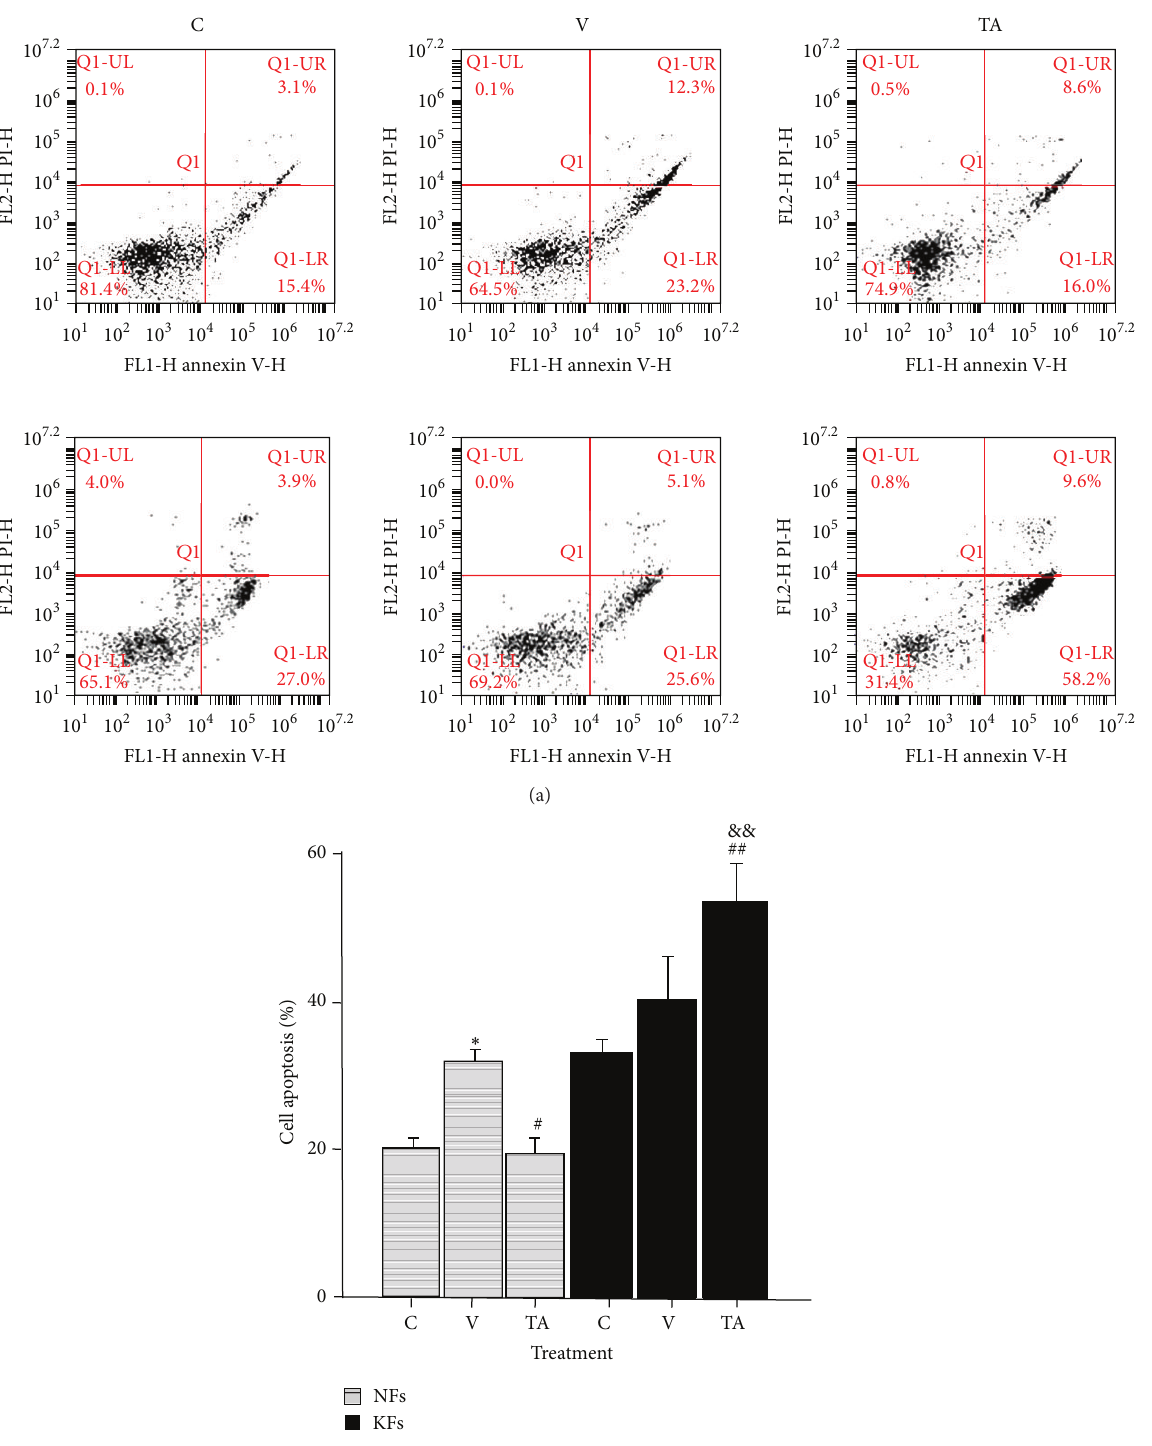
Figure 3: The effect of TA on cell apoptosis in NFs and KFs. DMSO induced early and late apoptosis in NFs and slightly induced early apoptosis in KFs. TA strikingly induced late apoptosis in KFs. C: control, total medium; V: vehicle, 0.55% DMSO; TA, 0.55 × 10 −3 M of TA was dissolved in 0.55% DMSO. ∗ 𝑃 < 0.01 , V versus C or TA; # 𝑃 < 0.05 , TA versus V; ## 𝑃 < 0.05 , TA versus C; && 𝑃 < 0.01 , TA versus TA; 𝑛 = 6